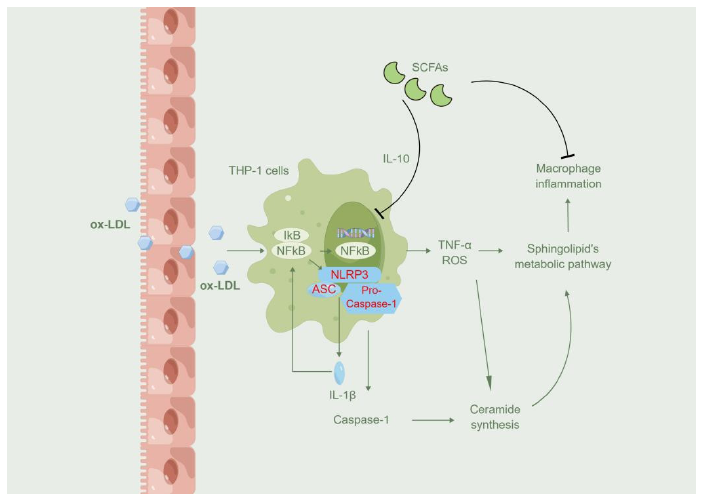
Figure 7. Schematic illustration of mechanism. Schematic illustration of the protective effects of SCFAs on ox-LDL-induced cell inflammatory injury via regulating the sphingolipid pathway and inhibiting the activation of the NLRP3/caspase-1 pathway.